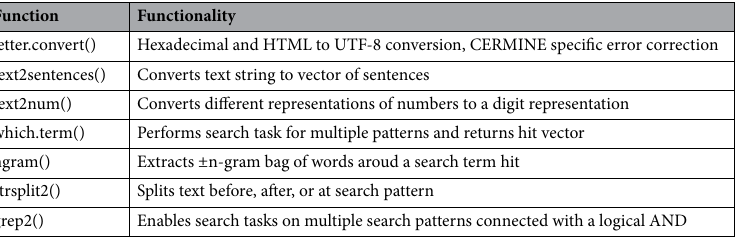
Table 1. General text processing functions implemented in JATSdecoder and their